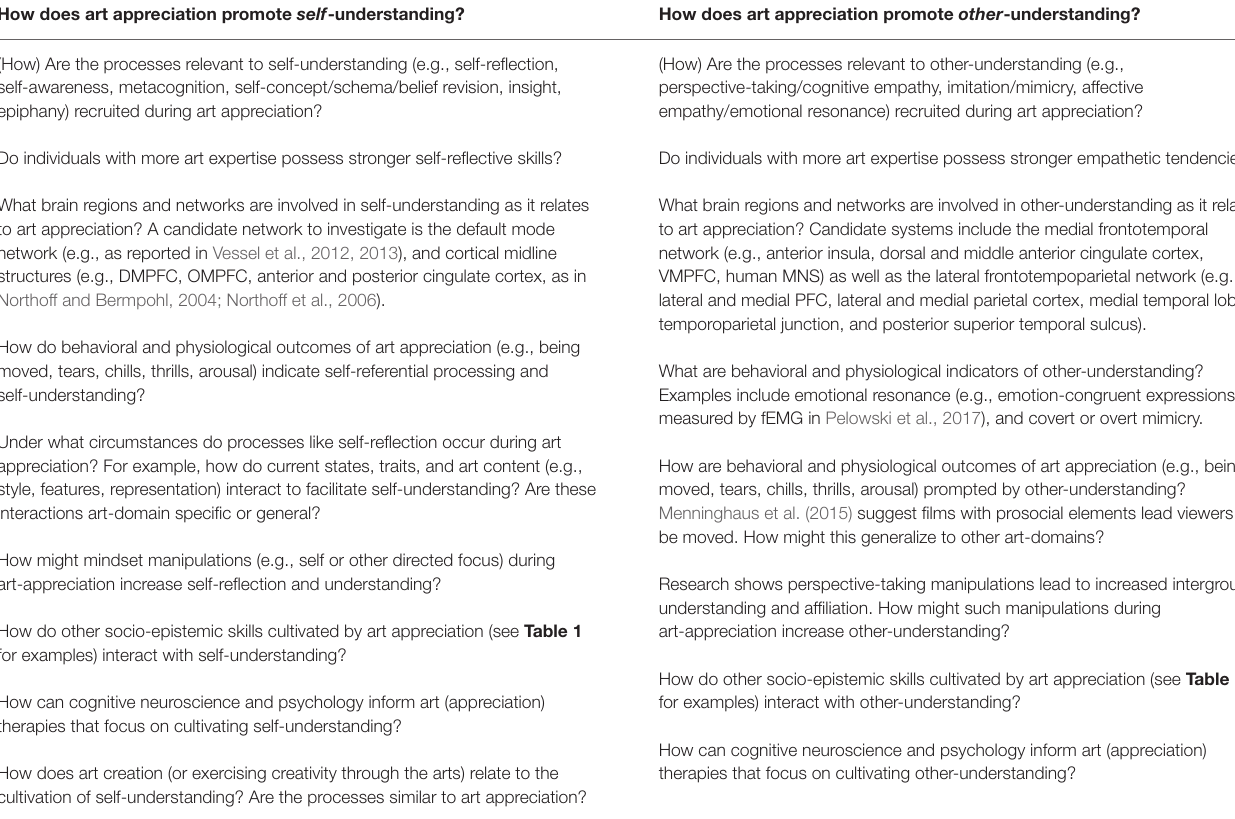
TABLE 2 | Open questions. How does art appreciation promote self -understanding? How does art appreciation promote other